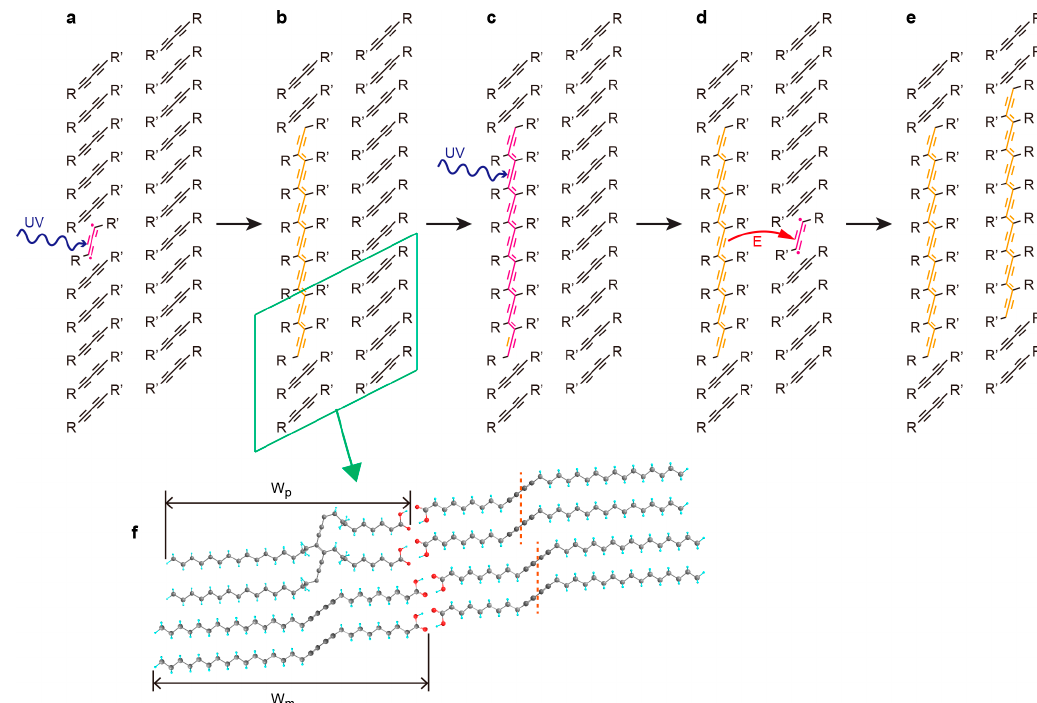
Figure 4. Schematic illustration of the self-sensitization of diacetylene on h-BN: ( a ) the diacetylene layer is exposed to UV-light and one of the molecules is excited; ( b ) a PDA chain is formed; ( c ) the PDA absorbs energy due to further irradiation; ( d ) energy is transferred to the neighboring monomer; and ( e ) this causes it to polymerize. R and R’ are (CH 2 ) 15 CH 3 and (CH 2 ) 8 COOH, respectively. ( f ) Detailed model of the area denoted by the rectangle in (b) . Orange dotted lines show the monomer arrangement defect near the polymer edge. W p and W m indicate the width of polymer and monomer, respectively.